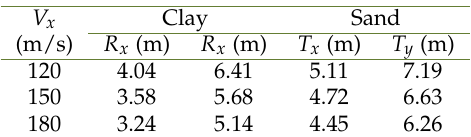
Table 2. Nominal length of the barrette used in this study V x Clay